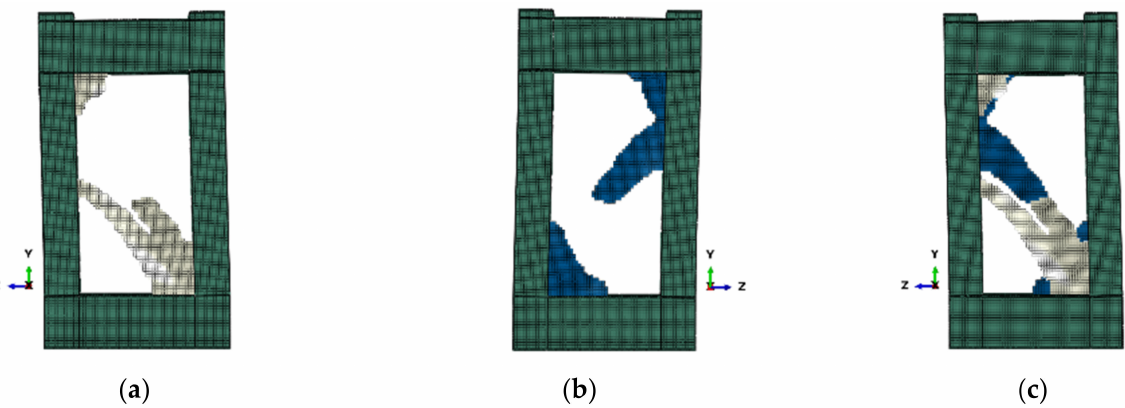
Figure 10. Nonlinear optimization results of SPSW with an aspect ratio of 2.0. ( a ) Front side. ( b ) Reverse side. ( c ) Distribution of stiffening